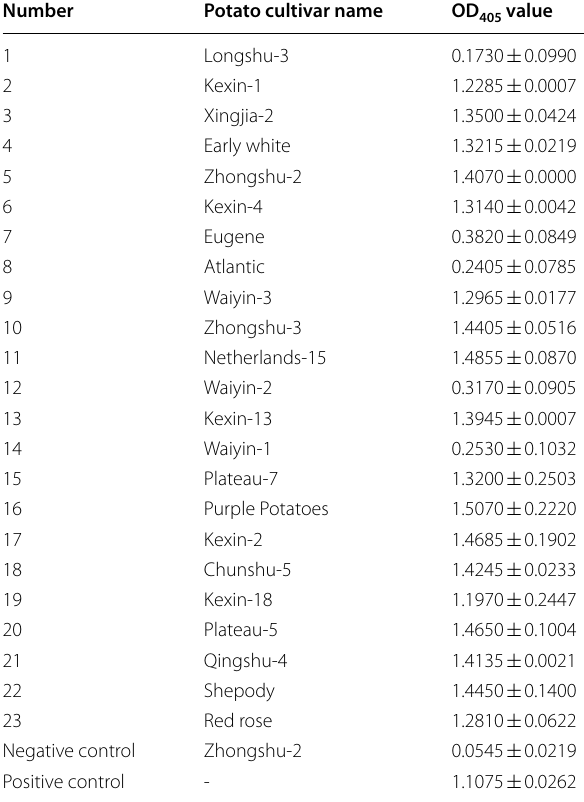
Five plantlets per cultivar were inoculated and equal amounts of systemic leaf tissues were mixed for ELISA at 12 dpi. Healthy Zhongshu-2 was used as a negative control and the positive control was provided in the ELISA Reagent Set for PVX